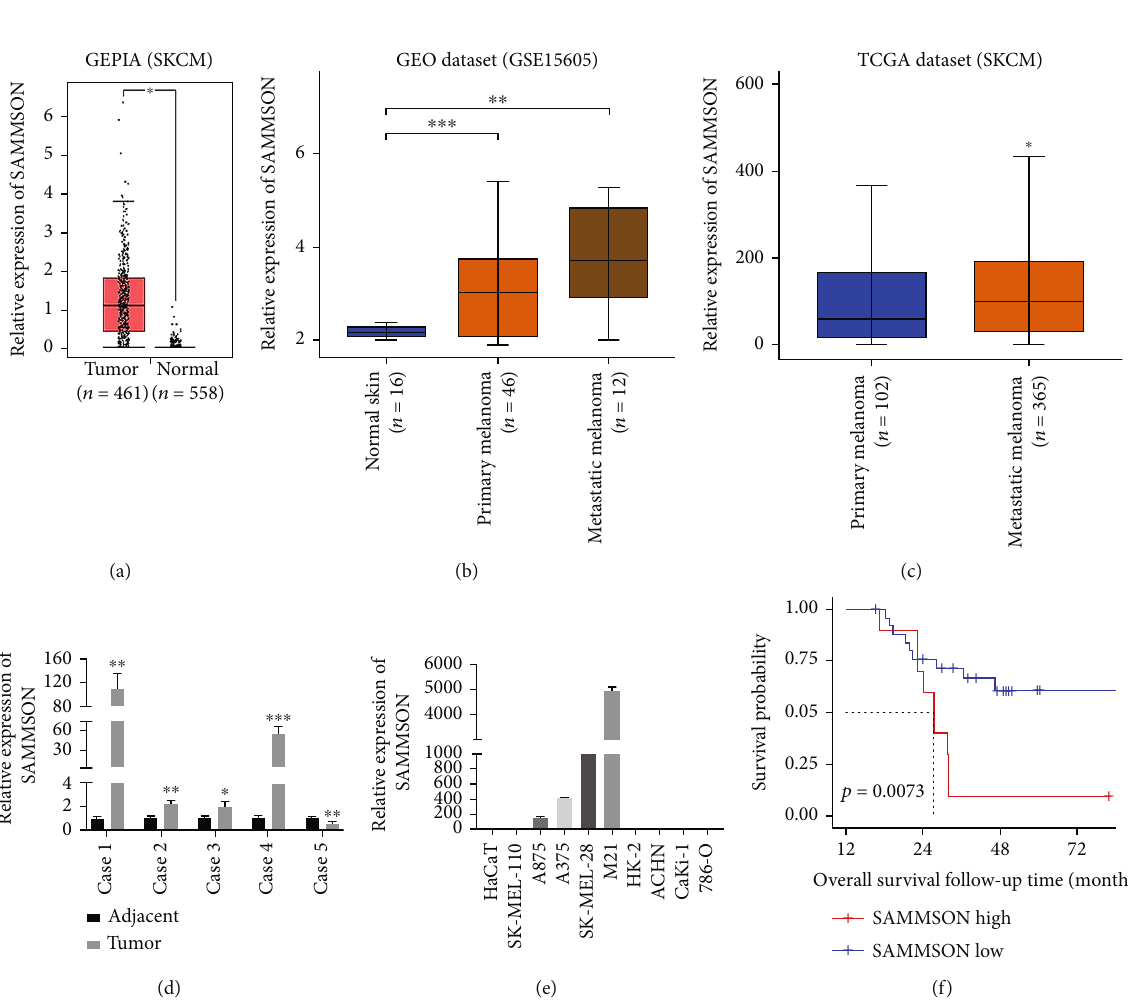
Figure 1: lncRNA SAMMSON is upregulated in human melanoma tissues and cell lines, and lower SAMMSON expression is associated with increased 10-year OS. (a) Analysis of the GEPIA database on the relative SAMMSON expression in melanoma tissue and normal tissue ( ∗ p < 0 : 05 , Mann – Whitney U test). (b) Analysis of the GEO database on SAMMSON expression in normal skin tissues, primary tumors, and metastatic melanoma tissues ( ∗∗ p < 0 : 01 , ∗∗∗ p < 0 : 001 , Mann – Whitney U test). (c) Analysis of the TCGA database on SAMMSON expression in primary tumors and metastatic tissues ( ∗ p < 0 : 05 , Mann – Whitney U test). (d) RT-qPCR analysis of SAMMSON expression in melanoma tissues and normal adjacent tissues ( ∗ p < 0 : 05 , ∗∗ p < 0 : 01 , and ∗∗∗ p < 0 : 001 , paired t -test). (e) RT-qPCR analysis of SAMMSON expression in human melanoma cell lines (SK-MEL-110, A375, A875, SK-MEL-28, and M21) and human renal carcinoma cell lines (ACHN, CaKi-1, and 786-O). The immortalized human keratinocyte cell line HaCaT and proximal tubule epithelial cell line HK-2 were used as controls. (f) Kaplan-Meier OS curves for patients with MM from the GSE19234 dataset ( p = 0 : 0073 , log-rank